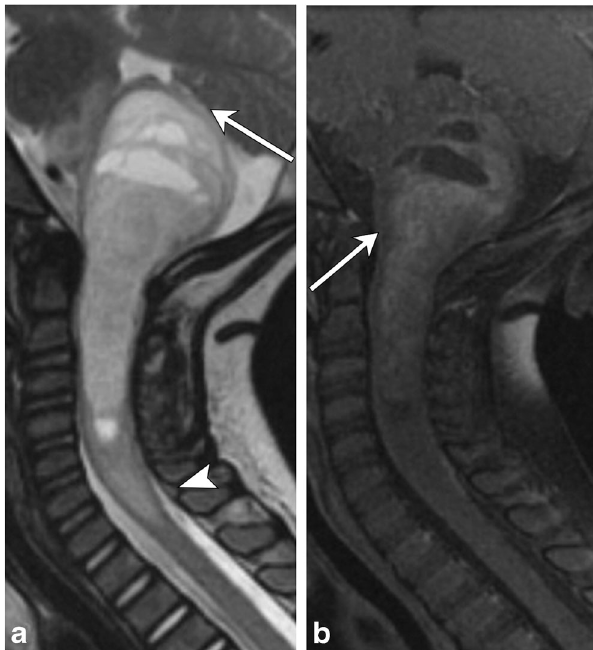
Fig. 15 Spinal astrocytoma. A 3 year old with a history of torticollis and ear pain. a Sagittal T2 image demonstrates a heterogeneous, expansile solid and cystic mass involving the upper cervical spine and brainstem, compressing the fourth ventricle and cerebellum (arrow). Mass/edema extends inferiorly to the C7-T1 vertebral level (arrowhead). b There is heterogeneous enhancement of the solid components on the T1 post- contrast image (arrow) (Table 3). Spinal cord astrocytomas will involve a long seg- ment, as will (but to a lesser extent) ependymomas, while hemangioblastomas and metastases typically involve short seg- ments. The enhancement pattern is essential in differentiating these lesions. In ependymoma, a solid, mostly homogeneous pattern of enhancement is typical, while astrocytomas will ex- hibit more heterogeneous enhancement. Other distinguishing features of ependymoma include presence of tumoral and nontumoral cysts and identification of a B cap sign ^ , which is a rim of T2 hypointense hemosiderin secondary to associated hemorrhage that can occur in about one-third of cases [24]. Table 3 Neoplastic lesion